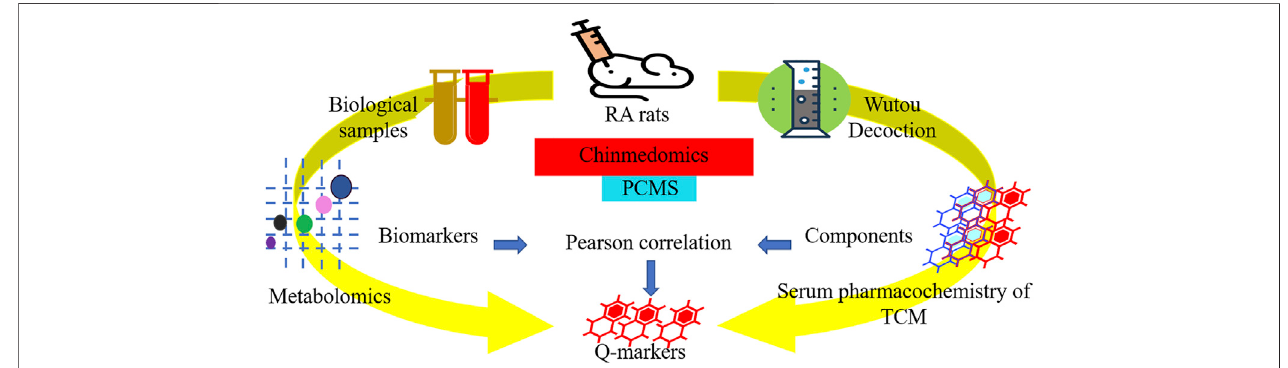
FIGURE 1 | The work fl ow of quality markers research for wutou decoction in the treatment of adjuvant-induced arthritis rat based on chinmedomics strategy.